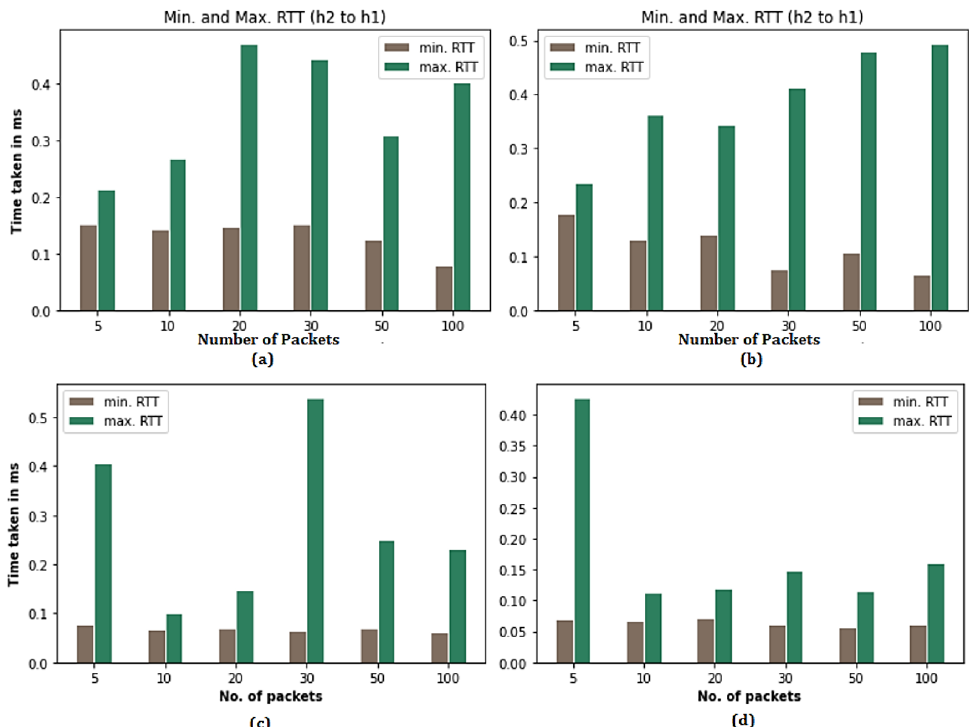
Figure 16. Min. and Max.RTT between h2 and h1, ( a , b ) AS65000/SDN as transit in legacy, ( c , d ) Min. and Max.RTT between h2 and h1 in SDN.